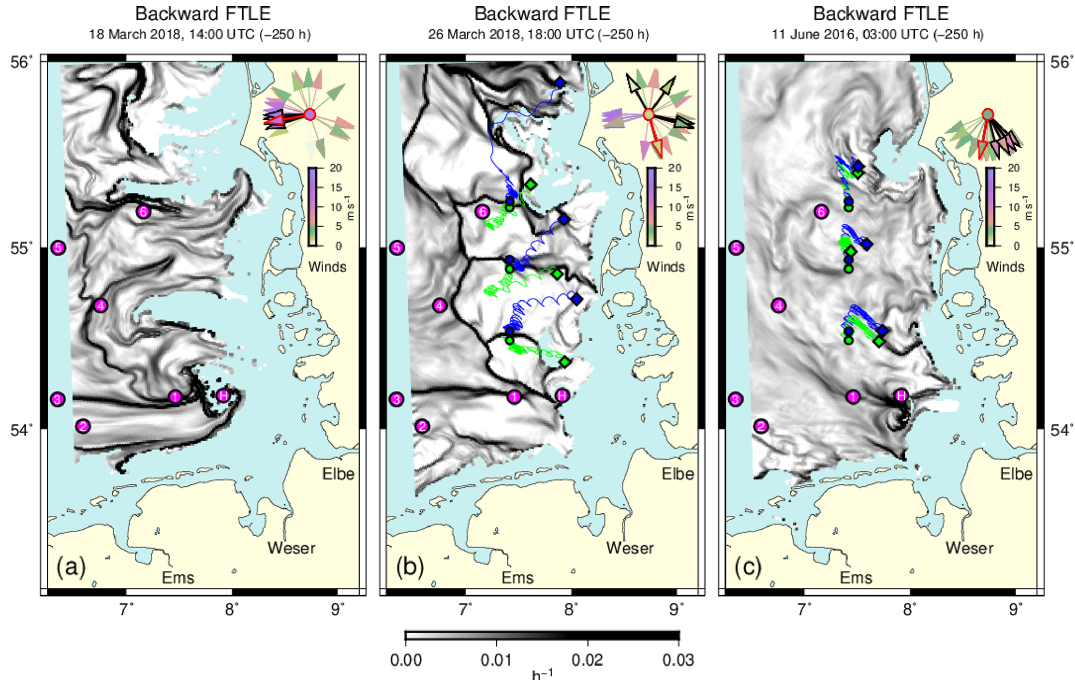
Figure 3. (a) Backward FTLE field (250h integration) for 18 March 2018 (14:00UTC). Magenta circles indicate the locations of the MARNET stations (1–6) and of the island of Heligoland (H). (b) Backward FTLE field about 8d later (26 March 2018, 18:00UTC). Three pairs of example trajectories (green and blue), started on either side of FTLE ridges, are shown. Trajectory release points are indicated by circles, and end points are indicated by diamonds. (c) Example of a much smoother backward FTLE field on 11 June 2016 (03:00UTC). For the purposes of comparison, backward trajectories were calculated from the same release points as those used in panel (a) . Vectors in the top-right corner of each panel show past wind directions (modelled for the location of MARNET station 4) at 10-hourly intervals. Different wind speeds are represented using different colours. Wind vectors at the times plots refer to are outlined in red and those during the previous 50h are outlined in